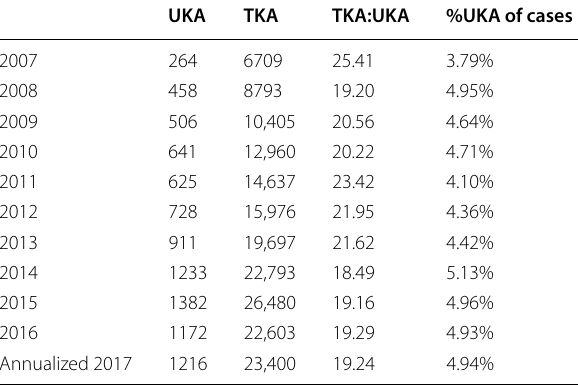
Table 2 Number of patients undergoing UKA or TKA by